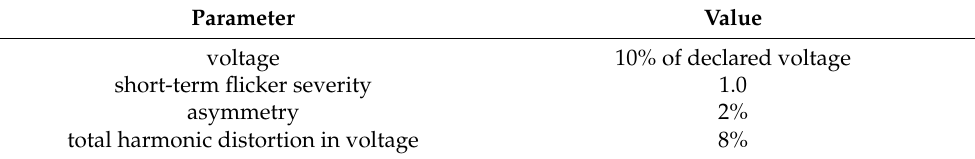
Table 1. Acceptable values base on standard EN 50160 [73] used for the global